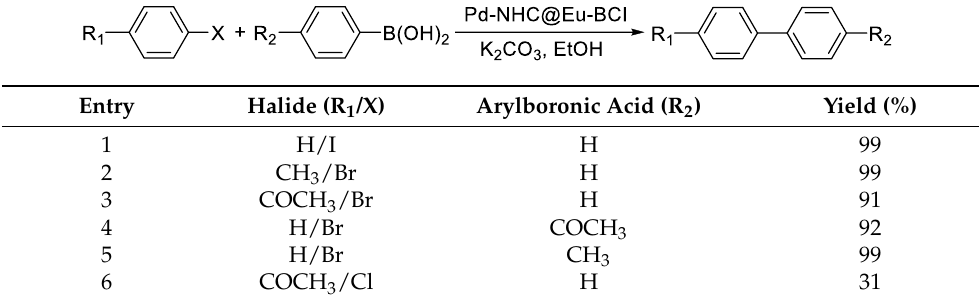
Table 2. Suzuki – Miyaura coupling reactions of aryl halides and arylboronic acids catalyzed by Table 2. Suzuki–Miyaura coupling reactions of aryl halides and arylboronic acids catalyzed by